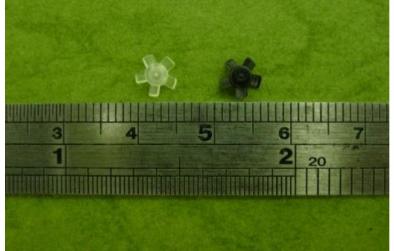
Figure 11. The molded micro-sized part by µ